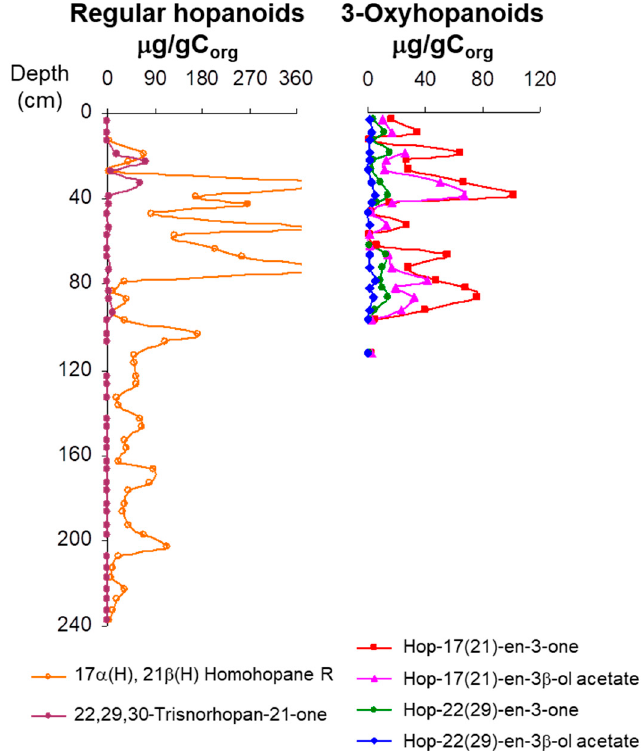
Figure 6. m / z 191 traces of two selected samples from the upper and lower part of the Roñanzas profile at 39 and 163 cm (R39 and R163) in the high retention time where hopanoids appear.